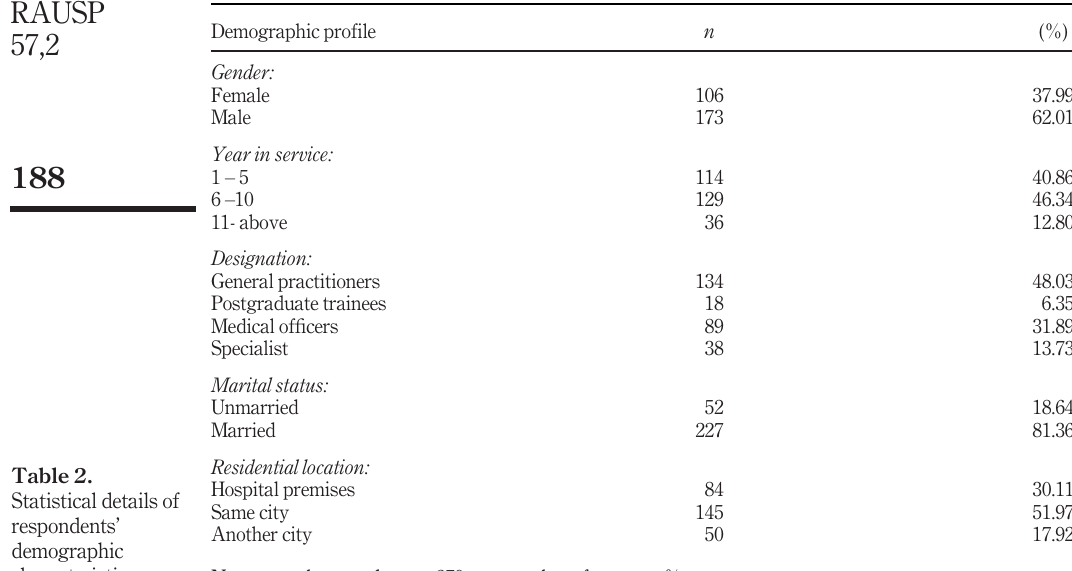
Table 2. Statistical details of respondents ’ demographic characteristics